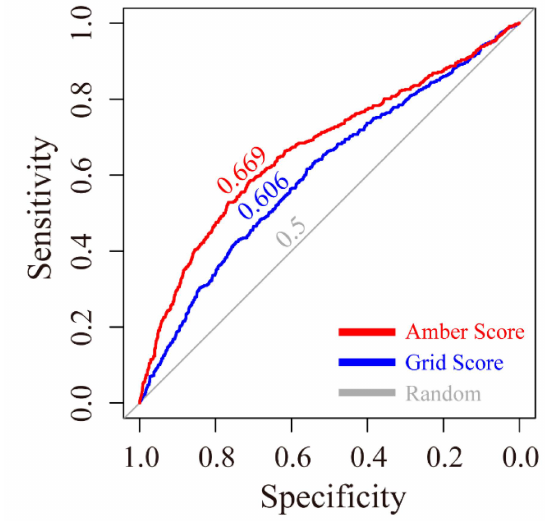
Figure 1. ROC evaluation of grid and amber scoring functions. Corresponding AUC values for each ROC curve are labeled above the line. Color code: Red—amber scoring function; Blue—grid scoring function;